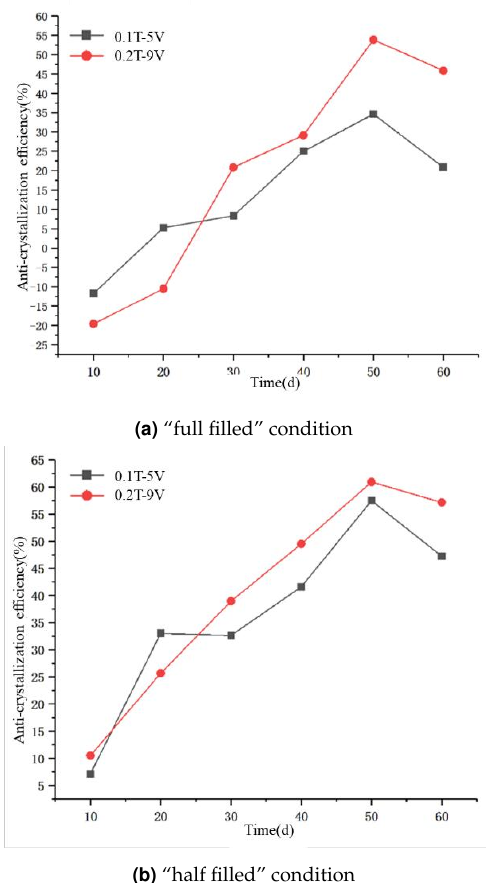
Fig. 13. Changes of the number of cumulative crystalline matters the treatment groups under the water filling condition over time.